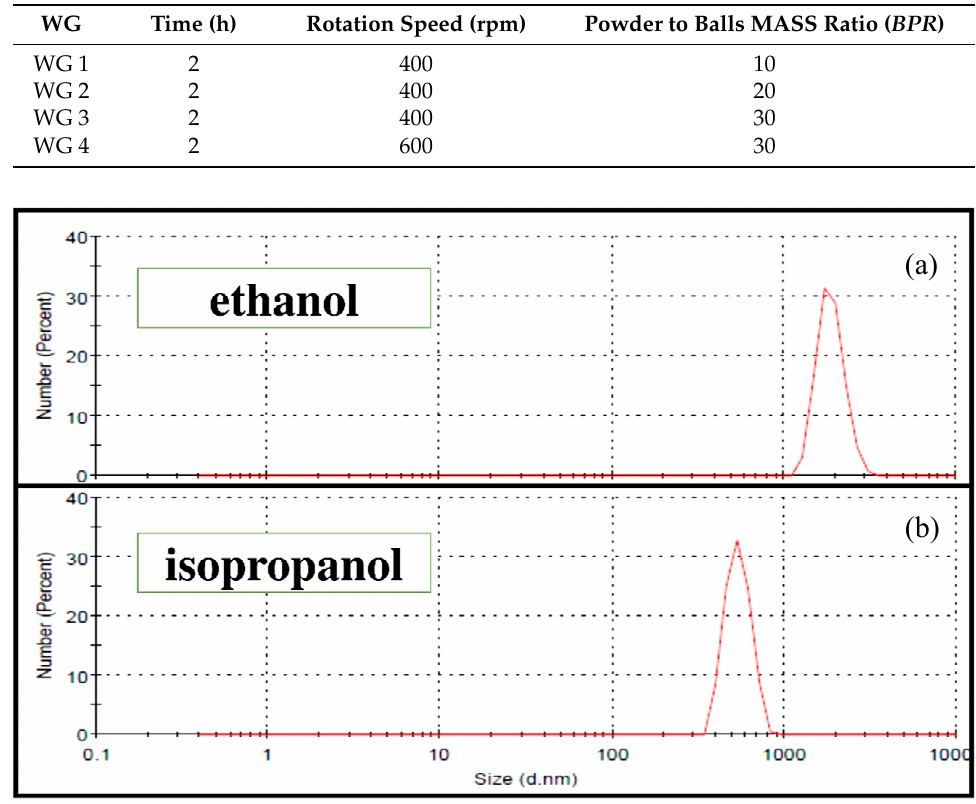
Figure 6. Methodology for the coating thicknesses measurement: ( a ) The sample is embedded into a resin block; ( b ) Cross-section of the resin block; ( c ) Optical observation of the cross-section.